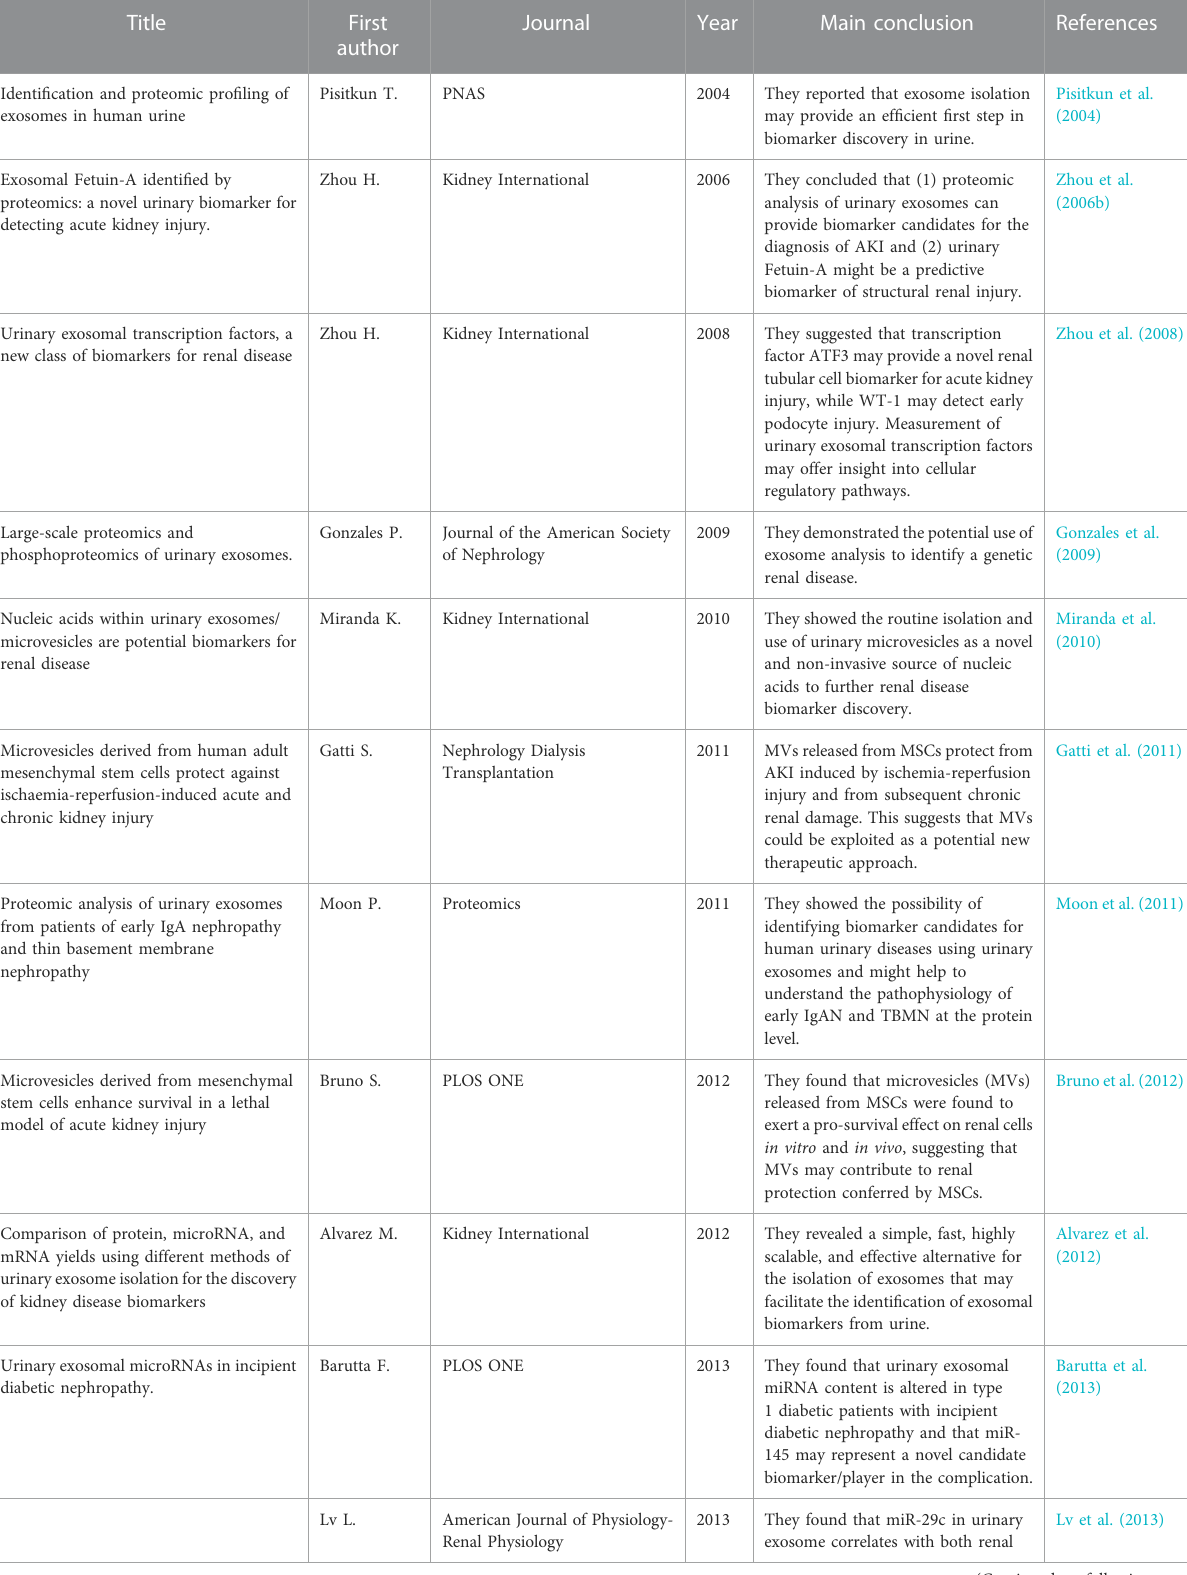
TABLE 5 Major achievement articles on EVs in kidney-related